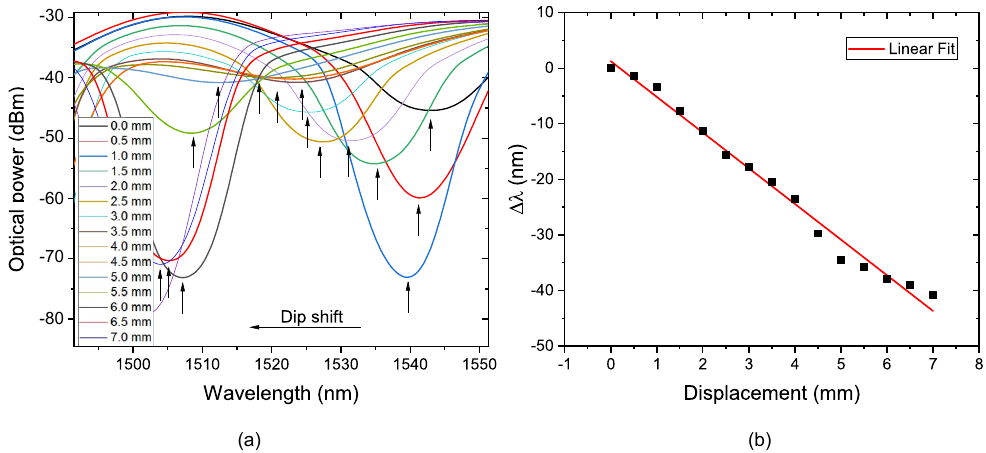
Figure 12. ( a ) Transmission spectrum of the sensor with supports; ( b ) linear fit of wavelength shift as a function of displacement. Table 2. Comparison of the results obtained in this